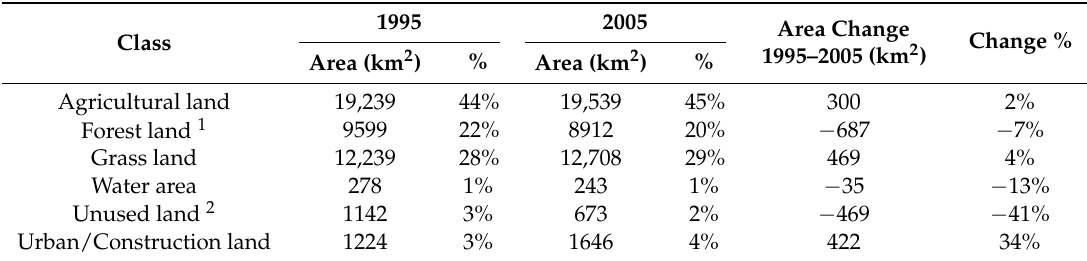
Table 3. The changes in land use between 1995 and